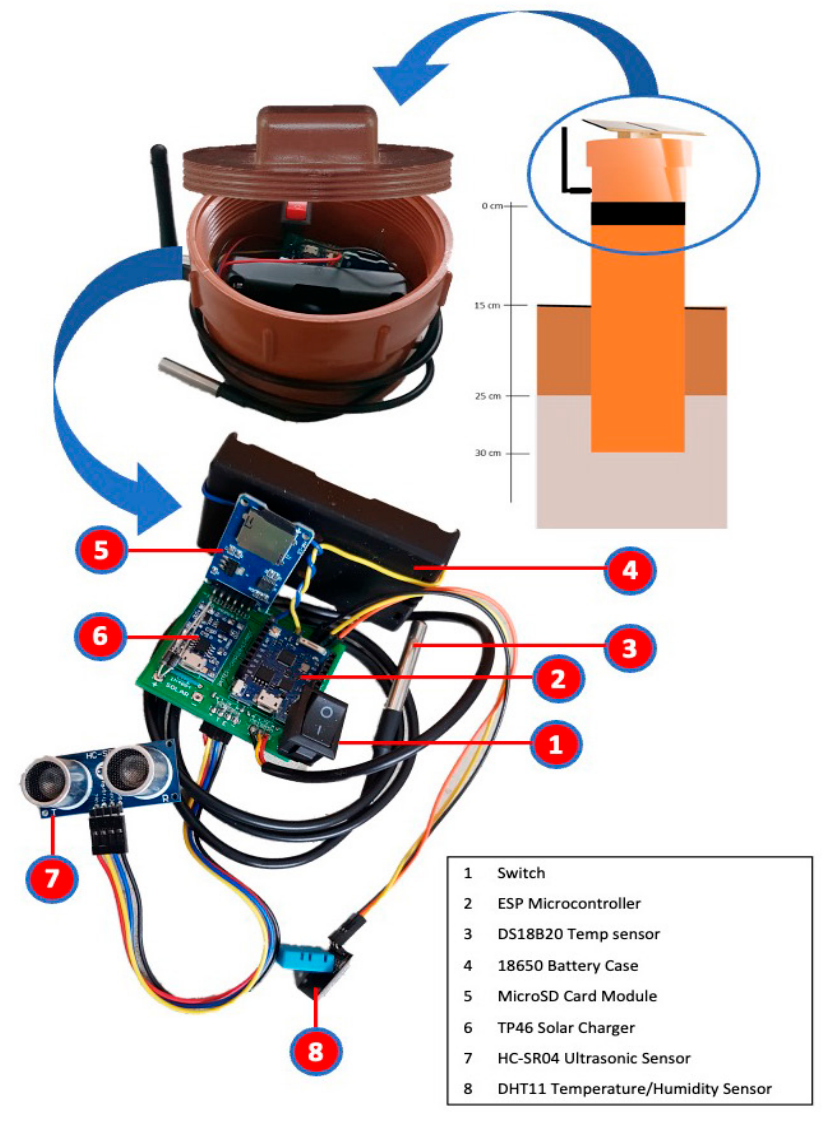
Figure 2. Low-cost sensor’s deployment setup and circuit assembly with labeled electronic com- ponents.